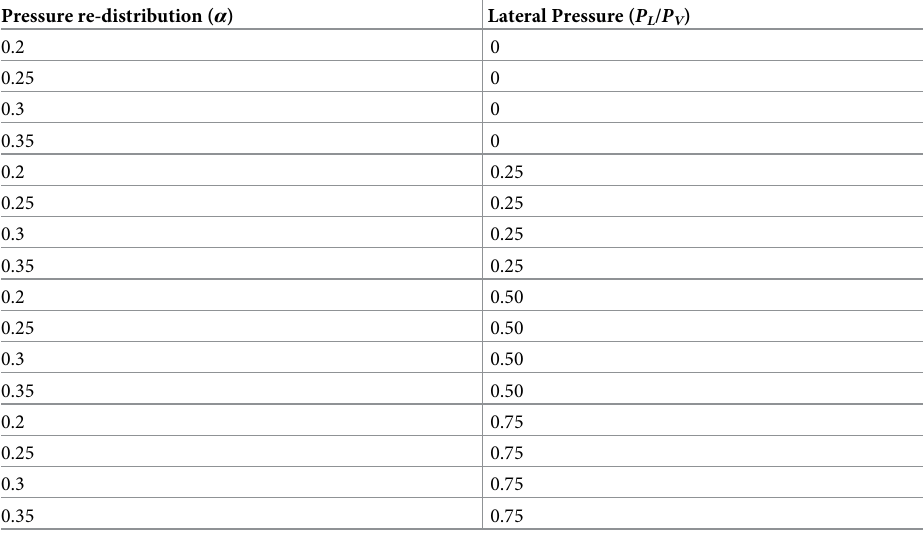
Table 2. Parameters governing the spread of the under-body pressure ( α ) and the magnitude of lateral pressure. Lateral pressure was defined relative to the peak under-body pressure ( P L / P V